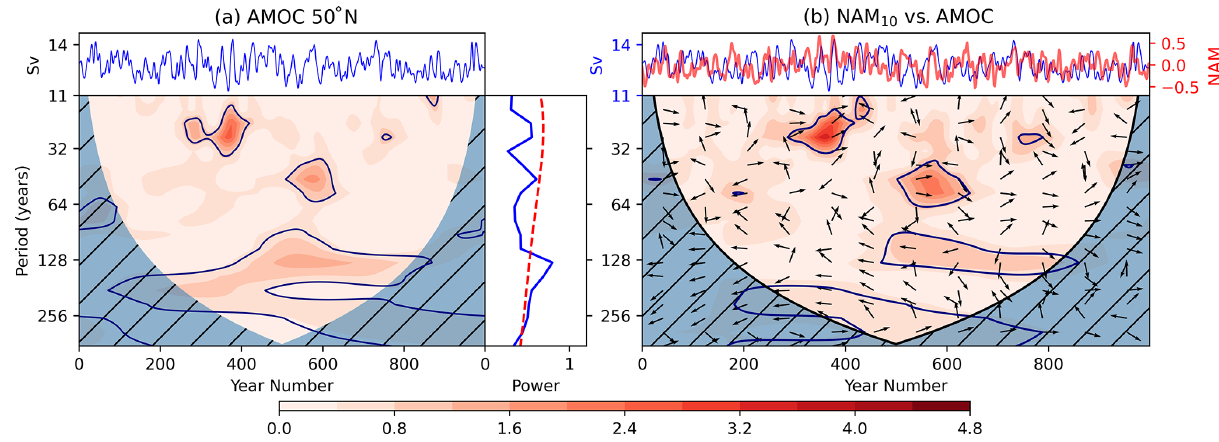
Figure 8. (a) AMOC time series at 50 ◦ N (top), wavelet power spectrum (shaded contours represent wavelet power and dark blue contours the 95% significance level compared to an AR1 process; bottom left), and global wavelet power spectrum (blue) and 95% confidence level (dashed red; bottom right). (b) Cross-spectra between filtered Dec–Mar NAM 10 series and the AMOC index, NAM 10 , and AMOC time series (top) and the cross-power spectrum (bottom). Shading indicates cross-power, dark blue contours the 95% confidence interval, and arrows the relative phase angle between signals in the time series (to the right – in phase; vertically upwards – π peaks in the NAM 10 leading those in the AMOC; to the left – π out of phase; vertically downwards – π the AMOC leading those in the NAM).